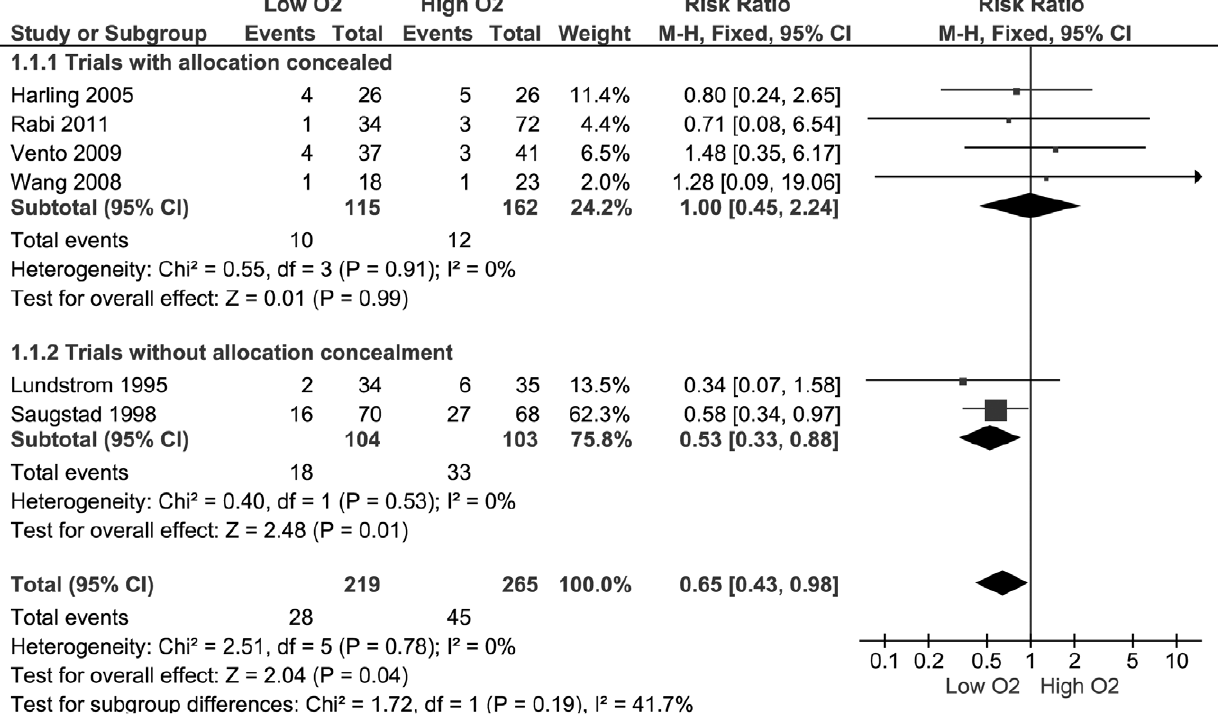
Figure 2. Meta-analysis of effect on mortality prior to hospital discharge. doi:10.1371/journal.pone.0052033.g002 PLOS ONE |